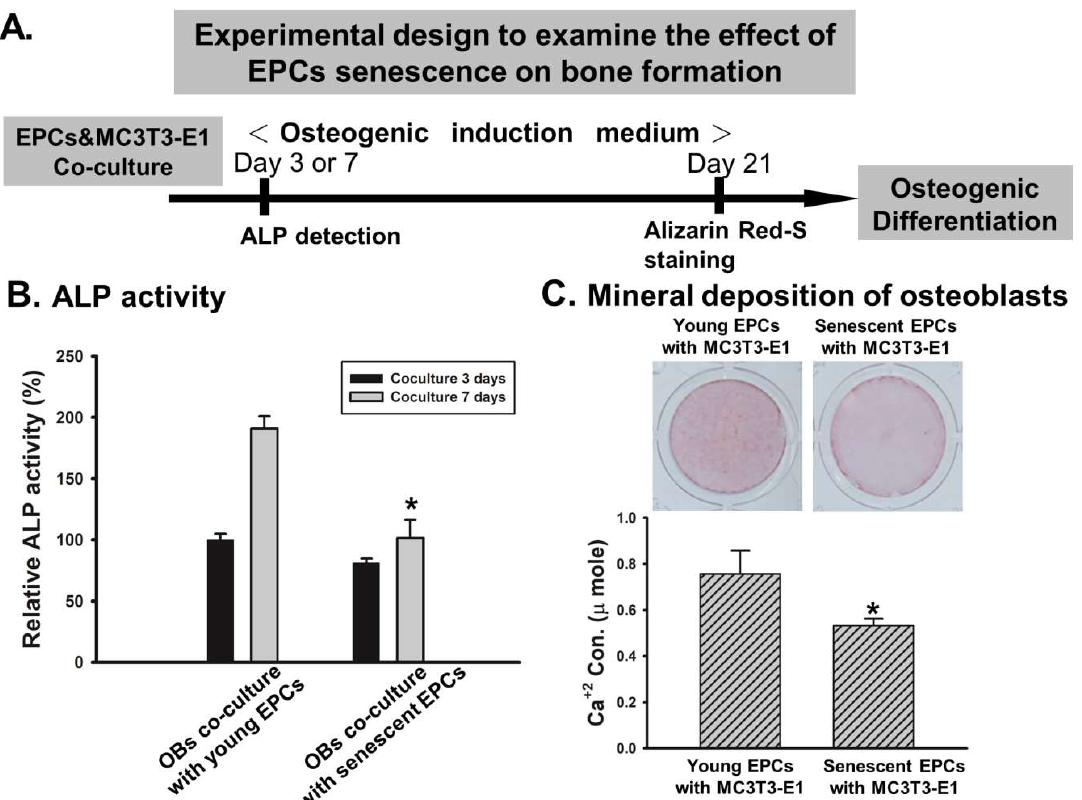
Figure 2. Effect of EPCs senescence on osteogenic function of osteoblasts. ( A ) Schematic diagram of the experimental design for EPCs and osteoblasts co-culture model. Murine osteoblast cell line (MC3T3-E1) cells were grown in co-culture with young or senescent EPCs, then incubated in the osteogenic induction medium for bone formation for the indicated times; ( B ) Alkaline phosphatase (ALP) activity of MC3T3-E1 cells decreased in co-culture with senescent EPC on day 3 and day 7 ( N = 5); ( C ) Calcium deposition was decreased in MC3T3-E1 cells after co-culture with senescent EPC for 21 days ( N = 5). Data are expressed as mean ± S.E.M. of five independent experiments. * p < 0.05 compared with the group of young EPCs.